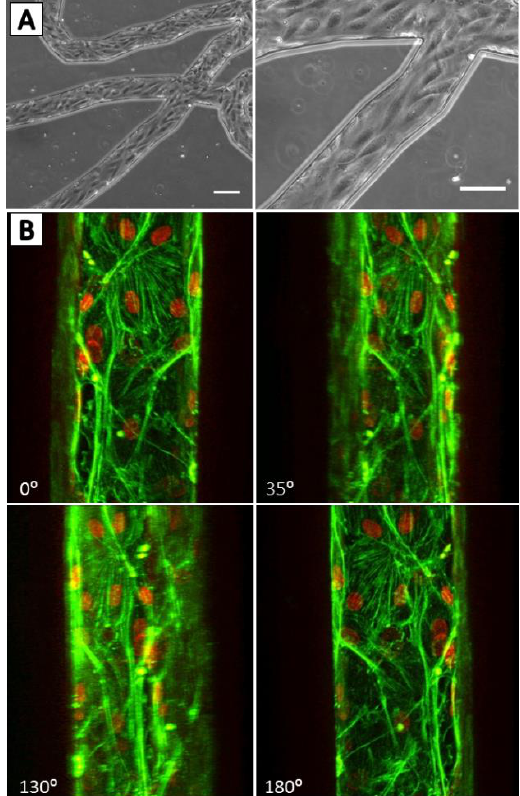
Figure 3. Endothelial cells form a complete lumen in the bMFA: ( A ) phase contrast images show endothelial cells are lined up in the direction of flow (scale bar is 100 µm). ( B ) Confocal micrograph of endothelial cells showing 3D lumen formation in the vascular channel; F-actin is labeled in green and nuclei is labeled in red. (Reproduced with permission from reference [120]).